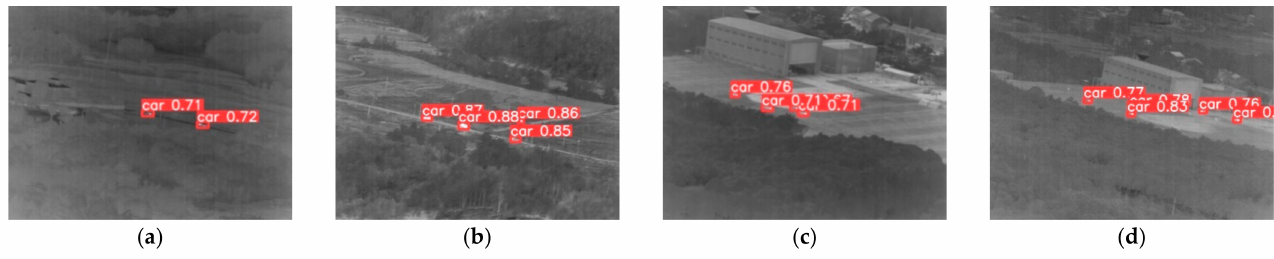
Figure 10. 16-1 DenseBlock detection results. ( a ) Scene 1. ( b ) Scene 2. ( c ) Scene 3. ( d ) Scene